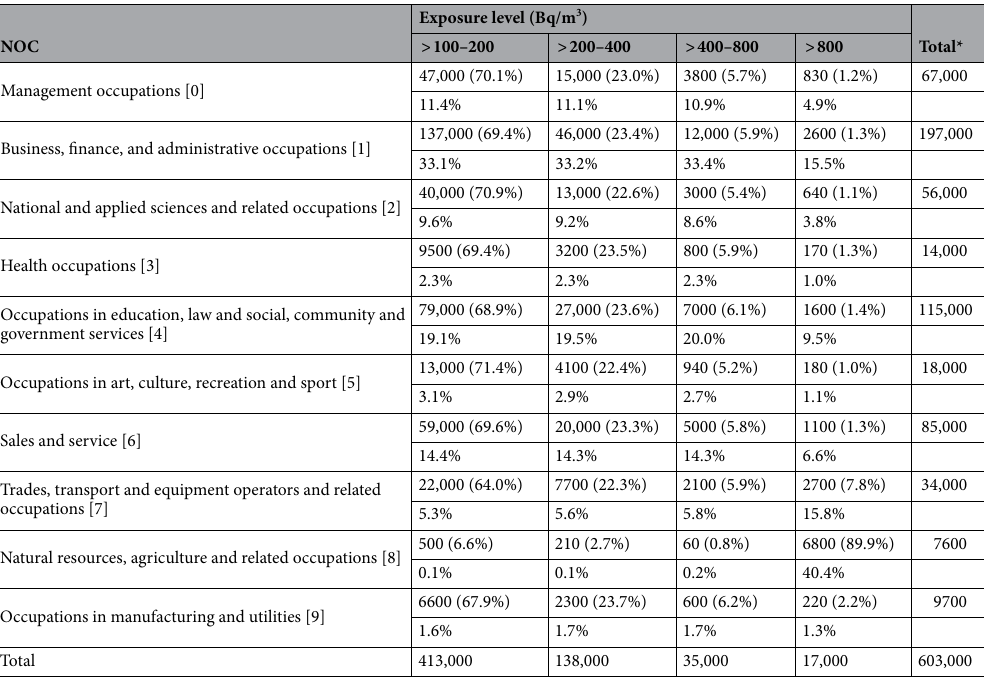
Table 4. Estimated number of workers exposed to radon by level of exposure and National Occupational Classification system (NOC 2016)—1-digit broad occupation. *Number of exposed may not add up to total because of rounding; row percentage in bracket; column percentage under each estimated